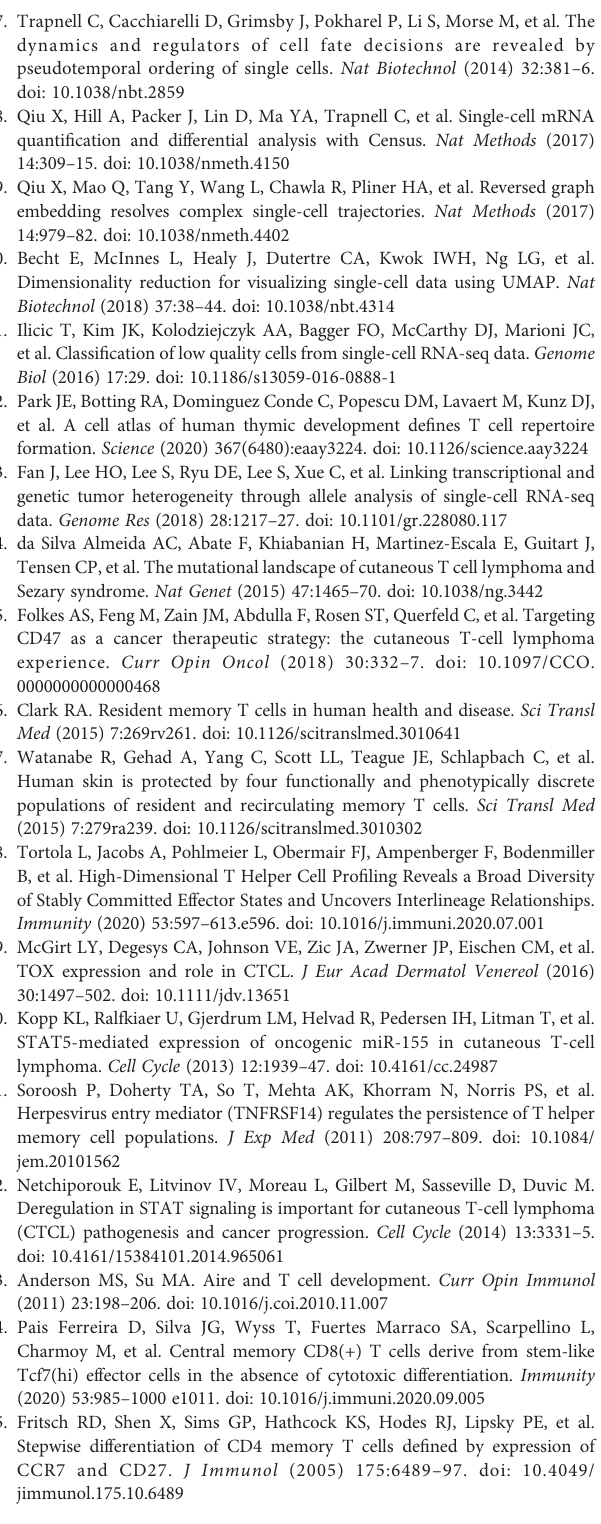
Supplementary Table 11 | Genes with branch dependent changes in gene expression according to branched expression analysis modeling (BEAM) fromthe R